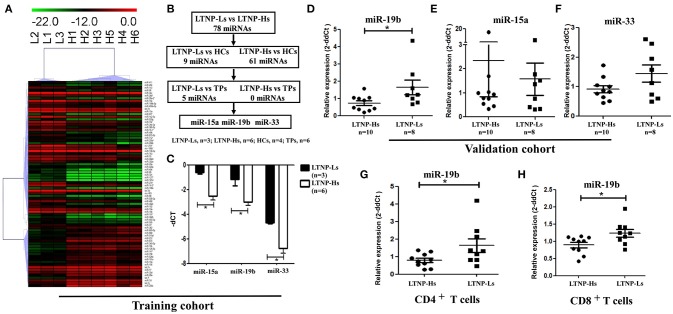
Expression of miR-19b is high in LTNP-Ls compared with that observed in LTNP-Hs. (A) Heatmap demonstrating 78 miRNAs differentially expressed between LTNP-Hs (n = 6) and LTNP-Ls (n = 3) in the training cohort (Benjamini–Hochberg false discovery rate-adjusted P < 0.05 and fold change >2). Hierarchical clustering of change in the threshold cycle (ΔCT) was performed using the complete linkage method and Pearson correlation coefficient. (B) The protocol for the selection of candidate miRNA from the training cohort. Among the 78 miRNAs differentially expressed between LTNP-Hs (n = 6) and LTNP-Ls (n = 3), 70 miRNAs differentially expressed between LTNPs and HCs (P < 0.05) were excluded. Subsequently, five differentially expressed miRNAs between LTNPs and TPs were excluded. Three candidate miRNAs, namely miR-15a, miR-19b, and miR-33 were selected. (C) Comparison of the three candidate miRNAs between LTNP-Ls (n = 3) and LTNP-Hs (n = 6) in the training cohort. (D,F) Relative expression of miR-19b (D), miR-15a (E) and miR-33 (F) in PBMCs obtained from LTNP-Ls (n = 8) and LTNP-Hs (n = 10) in the subsequent validation group. (G,H) CD4+ and CD8+T cells from LTNPs were sorted through flow cytometry. The expression of miR19b in CD4+
(G) and CD8+ T (H) cells was compared between LTNP-Ls (n = 9, one from training cohort, eight from validation cohort) and LTNP-Hs (n = 10, two from training cohort, eight from validation cohort) using qRT-PCR. *P < 0.05.